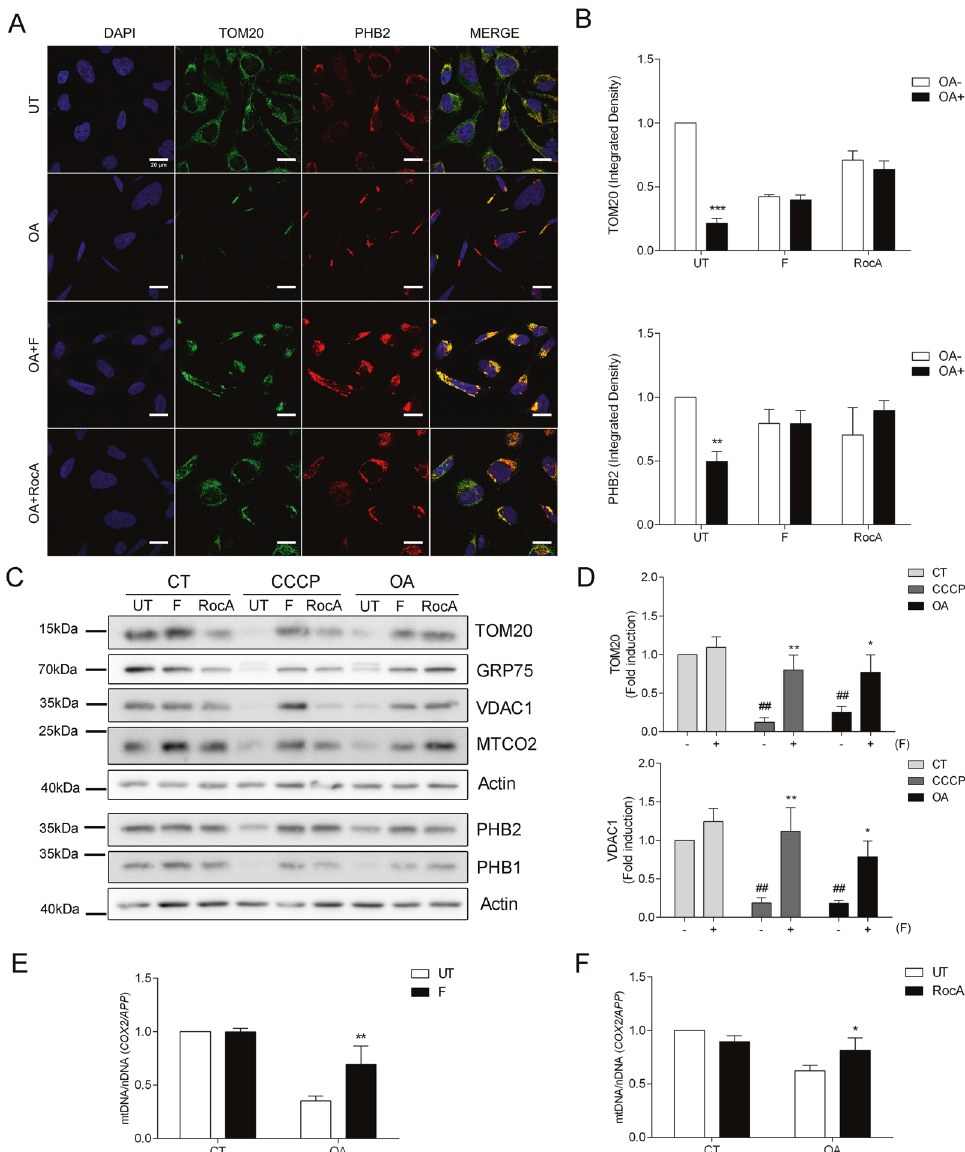
Fig. 2 Fluorizoline inhibits the removal of damaged mitochondria. HeLa Parkin cells (CT) were treated with 20 μ M pan-caspase inhibitor Q- VD-OPh ( A , B , E , F ) or not ( C , D ) while treated for 16 h with 1 μ M oligomycin/1 μ M antimycin (OA) or 10 μ M CCCP, in the absence (UT) or presence of 10 μ M fl uorizoline (F) or 500 nM rocaglamide A (RocA). Cells were co-immunostained for DAPI (blue), TOM20 (green), and PHB2 (red) and co-localization was analyzed by confocal microscopy ( A ). The integrated density of TOM20 and PHB2 was quanti fi ed. Mean ± SEM ( n = 3 independent experiments) ( B ). Protein levels from whole-cell lysates were analyzed by western blot and actin was used as a loading control ( C ). TOM20 and VDAC1 protein expression levels were quanti fi ed. Mean ± SEM ( n = 3 independent experiments) ( D ). The genes for COX II and the amyloid precursor protein (APP) were ampli fi ed and measured by RT-qPCR as indicatives of mitochondrial and nuclear DNA, respectively. Mean ± SEM ( n = 3 independent experiments) ( E , F ). These are representative images of three independent experiments ( A , C ). ** p < 0.01 and *** p < 0.001 CT versus OA-treated cells ( B ); * p < 0.05, ** p < 0.01 UT versus F or RocA-treated cells ( D − F ); ## p < 0.01 CT versus CCCP and OA-treated cells ( D